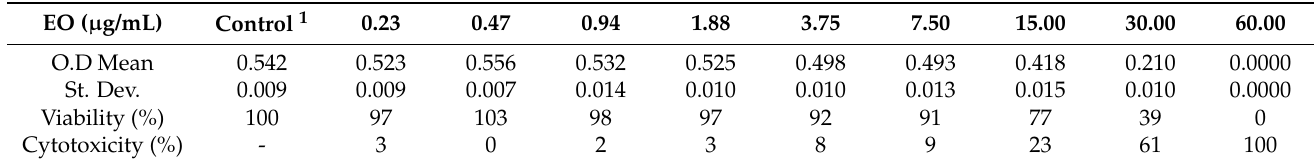
Table 5. Cytotoxic determination of EO on HaCaT keratinocytes (48 h incubation time, narrow EO concentration